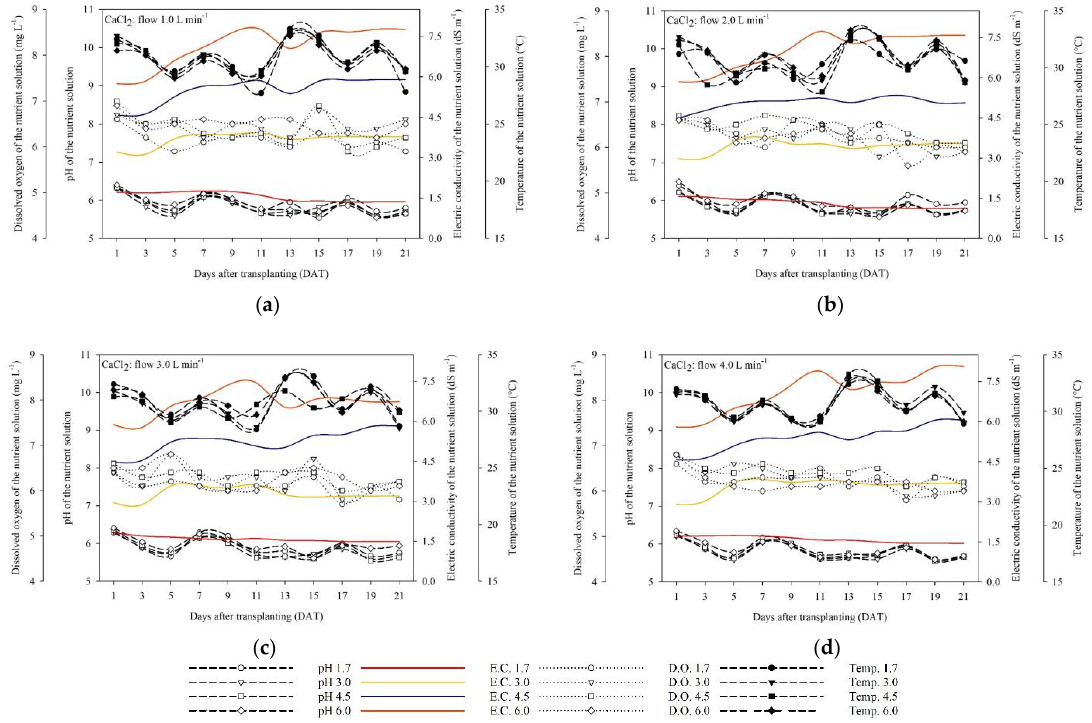
Figure 5. Values of electrical conductivity, pH, dissolved oxygen and temperature of nutrient solutions that were prepared in brackish water with a prevalence of CaCl 2 .2H 2 O and used in cultivation of coriander plants, cv. Verdão, applied in different flows (1.0 ( a ), 2.0 ( b ), 3.0 ( c ) and 4.0 ( d ) L min − 1 ). In general, it was verified in both cultivation cycles that the pH of the nutrient solu- tion (pHns) fluctuated in initial value within the range between 5.42 and 6.75 with the prevalence of NaCl in water (Figure 4a – d). Moreover, it was between 5.54 and 6.50 with CaCl 2 .2H 2 O, which was used to prepare the brackish water (Figure 5a – d). The dissolved oxygen concentration in the nutrient solution (DOns) ranged from 5.3 to 7.0 mg L −1 for all the treatments, whose mean values were 6.10 and 6.26 mg L −1 in the cultures with the cationic predominance of NaCl and CaCl 2 ·2H 2 O, respectively (Figures 4a – d and 5a – d). It was possible to observe in the final crop cycle that those coriander crops were cul- tivated with brackish waters and a prevalence of calcium. So, there were reductions in the DOns levels of up to 12.45%. Thus, the dissolved oxygen was compared to the first cycle in all treatments. This was different to the sodium chloride that was also used in the ex- periment. So, small positive and negative variations up to 2.11% were verified. The excep- tion was the treatment by the ECns of 4.5 dS m −1 and the flow of 3.0 L min −1 , in which there was an increase of 8.51% in the dissolved oxygen of the nutrient solution. In general, the temperatures of the nutrient solutions were similar in those two ex- periments, independently of the cationic predominance, the electrical conductivity, or the application rate of the nutrient solution. In the first cycle of nutrient solutions, which were prepared in salinized water with NaCl, it was found that the temperatures of those liquids varied between 28.8 and 32.7 °C, with an average of 30.8 °C, while in the second cycle with the salinization of CaCl 2 ·2H 2 O, the average temperature was 30.7 °C and ranged between 27.7 and 33.3 °C (Figures 4a – d and 5a – d). 3.2. Dry Mass, Plant Height, Water Content, and Water Consumption The interaction between the treatments (ECns × flow) influenced ( p ≤ 0.01) the plant height (PH) in both cycles, and there was also a significant effect ( p ≤ 0.05) on water con- sumption (WC) when CaCl 2 ·2H 2 O was used. The isolated, electrical conductivity of the nutrient solution (ECns) affected ( p ≤ 0.01) the dry mass of the aerial part (DMAP), the PH, and the WC in both experiments, and it also caused a significant effect ( p ≤ 0.05) on the water content in the aerial part (WCAP) under the prevalence of CaCl 2 .2H 2 O. The nutrient solution flow rate affected ( p ≤ 0.01) WC and ( p ≤ 0.05) DMAP (Experiment I), and it also influenced ( p ≤ 0.01) DMAP, WCAP, and ( p ≤ 0.05) PH (Experiment II) (Table 2).